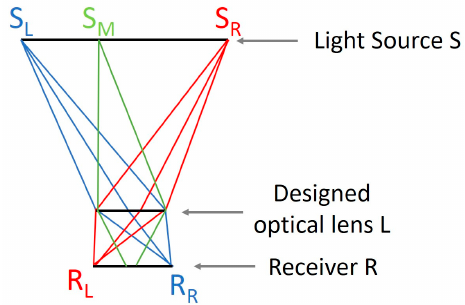
Figure 5. The basic of the edge ray principle, in which the illumination energy from light source S is transferred to receiver R without needed image formation.